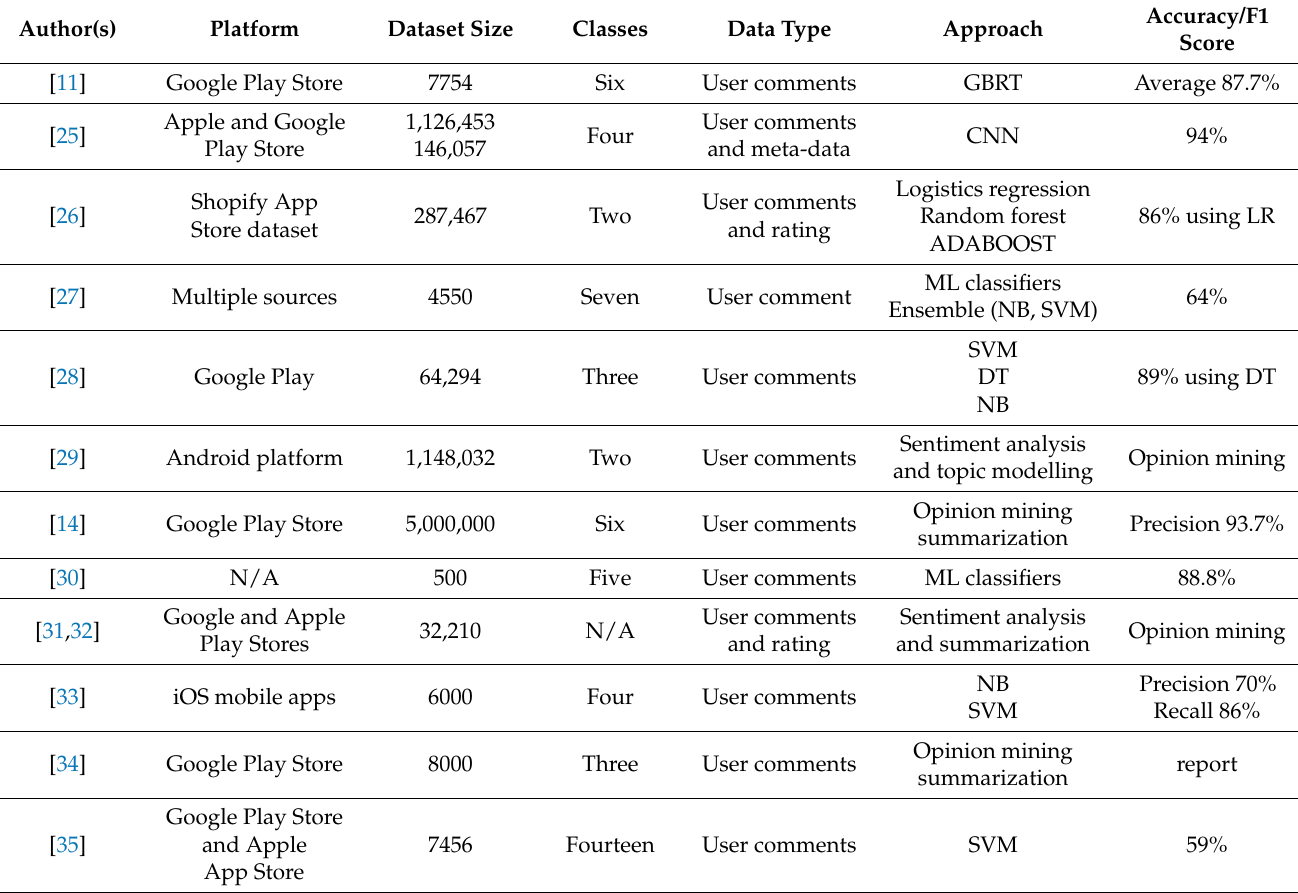
Table 1. Comparative analysis between mobile apps user mining